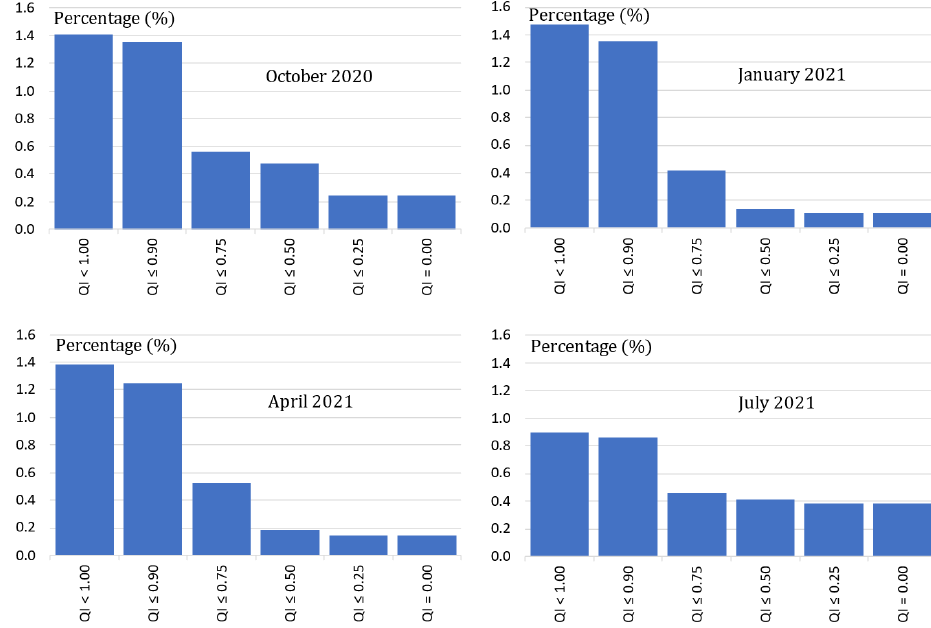
Figure 10. Percentage of rain gauge observations with a specified QI reduction after quality control. From the top: percentage contribution in each QI interval; cumulative percentage contribution (in %). From left: October 2020, January, April, and July